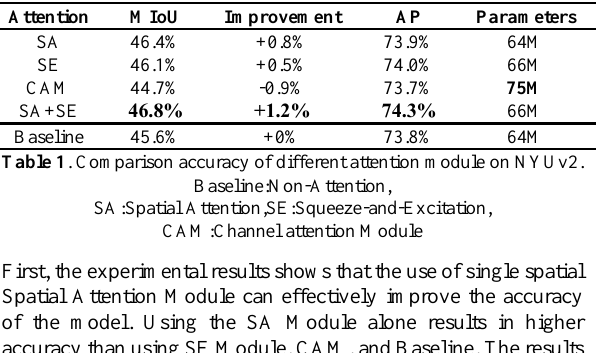
Figure 6. Framework of PSCNet